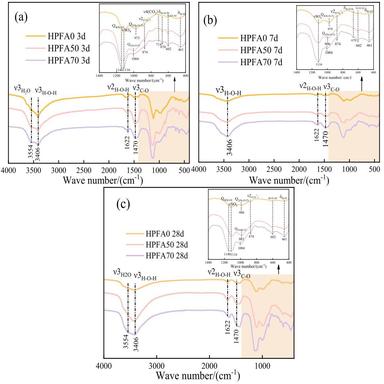
FTIR spectra of different HPFA dosage specimens. (a) 3-day age,(b) 7-day age,(c) 28-day age.